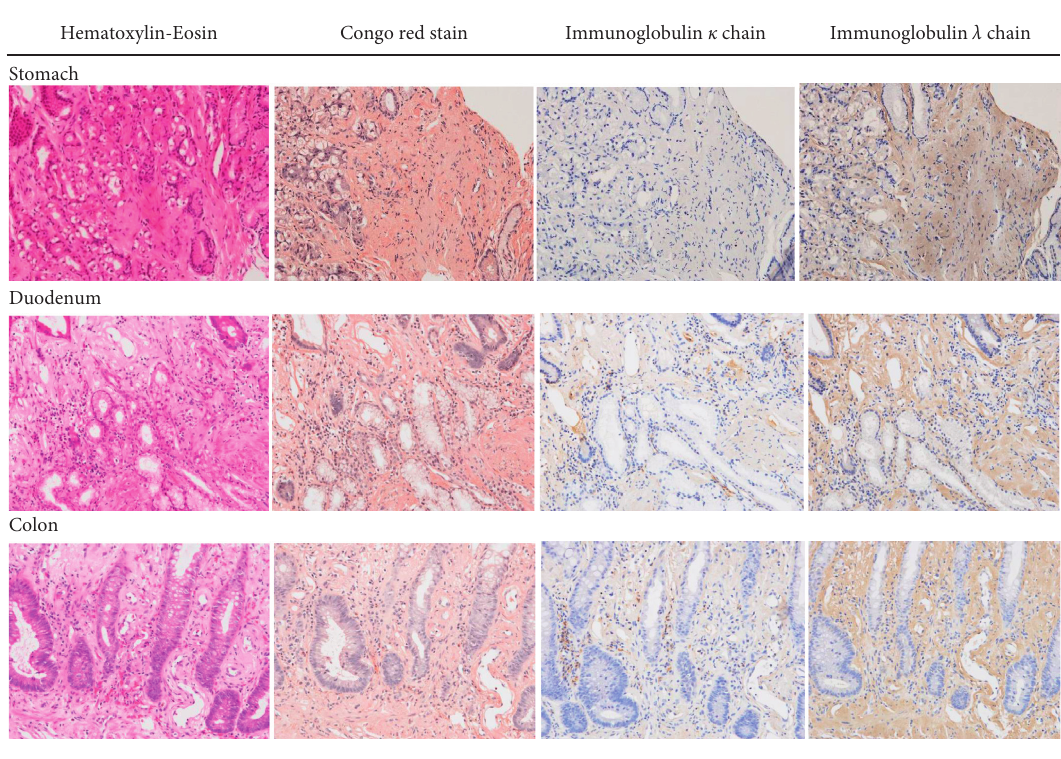
Figure 4: Histopathological findings of gastrointestinal biopsy. Histopathological examination showed Congo-red-positive amyloid deposits in the muscularis mucosae and submucosa of the stomach, duodenum, colon, and rectum. Immunohistostaining showed that the amyloid fibrils were composed of immunoglobulin λ light chains.